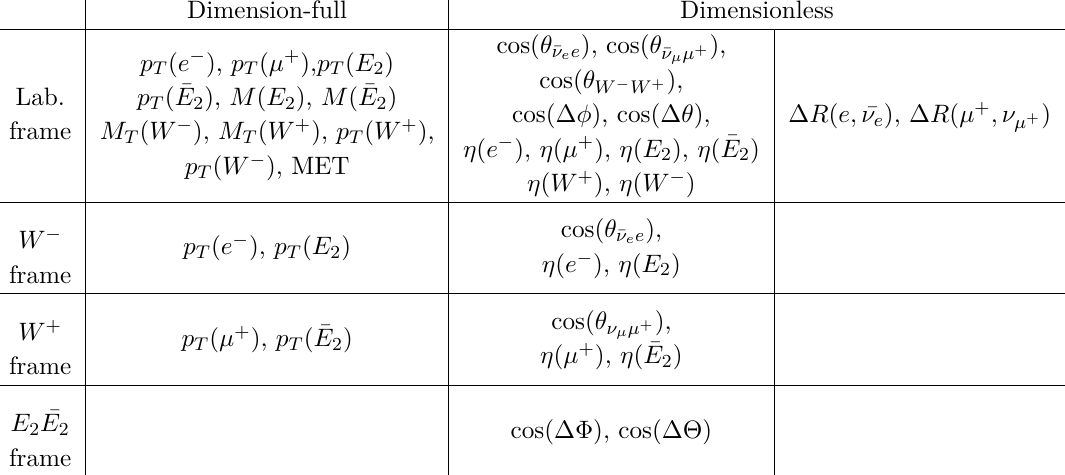
Table 3. Angular and kinematic observables selected for study of the pair-production topologies, for different frames of reference, the laboratory frame (in the first row), W + and W − frames (in the second and third row, respectively) and the vector-like frame E 2 ¯ E 2 (last row). θ i,j denotes the angle between different particles, either in the final state or reconstructed ones. In the E 2 ¯ E 2 frame, the angles ∆Φ and ∆Θ correspond to the azimuthal and polar angles formed by the decay plane of the two W bosons (see [26]).